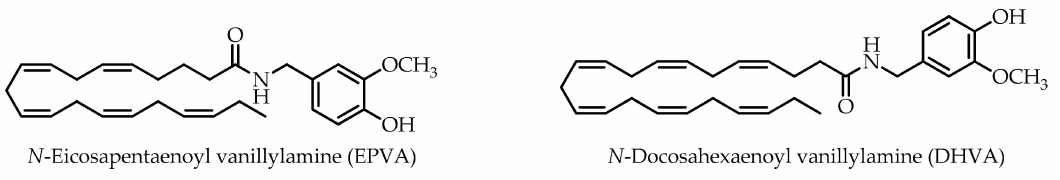
Figure 1. n -3 polyunsaturated fatty acid (PUFA)-derived capsaicin